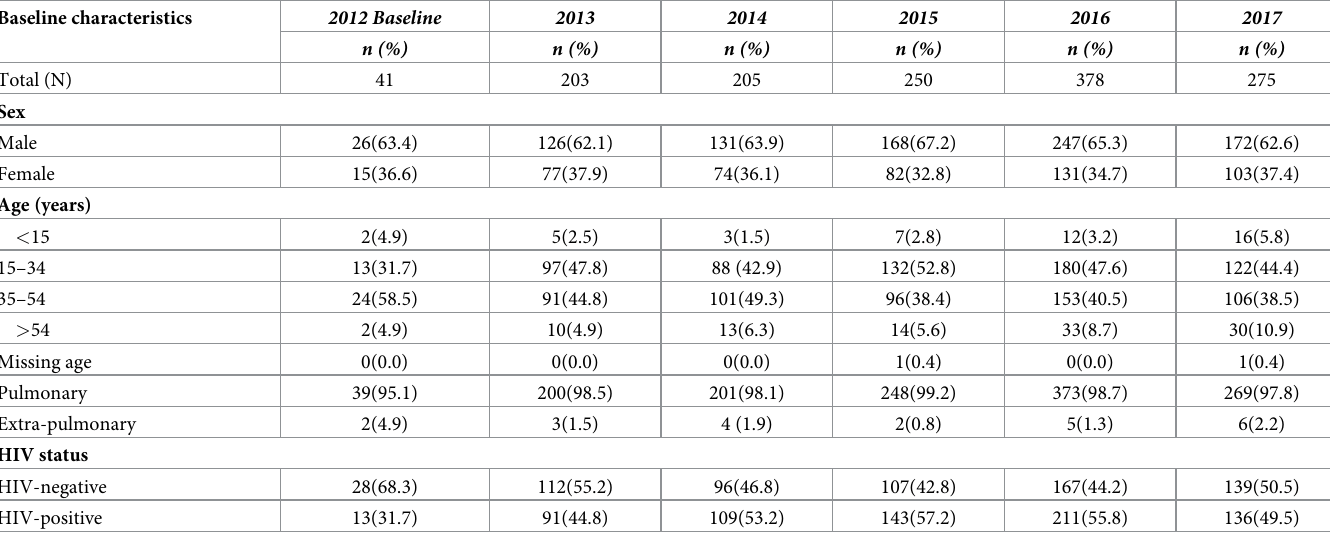
Table 2. Characteristics of RR-TB/MDR-TB patients enrolled for treatment in 2012 and 2017.